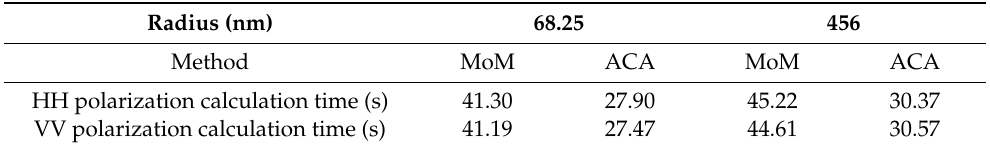
Table 2. Time comparison between MoM and ACA calculation with radius 68.25 nm and 456